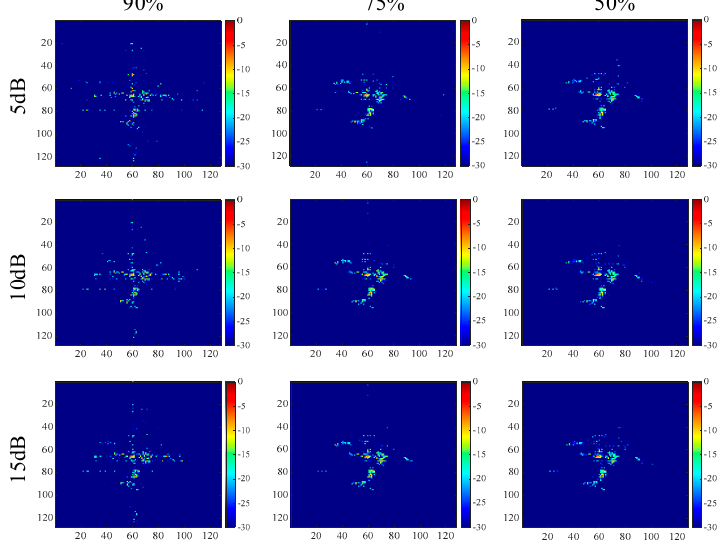
Figure 10. ISAR images of another measured dataset with different loss rates and different SNRs. Table 11. Performance evaluation for another measured dataset with different loss rate under dif- ferent SNR conditions.